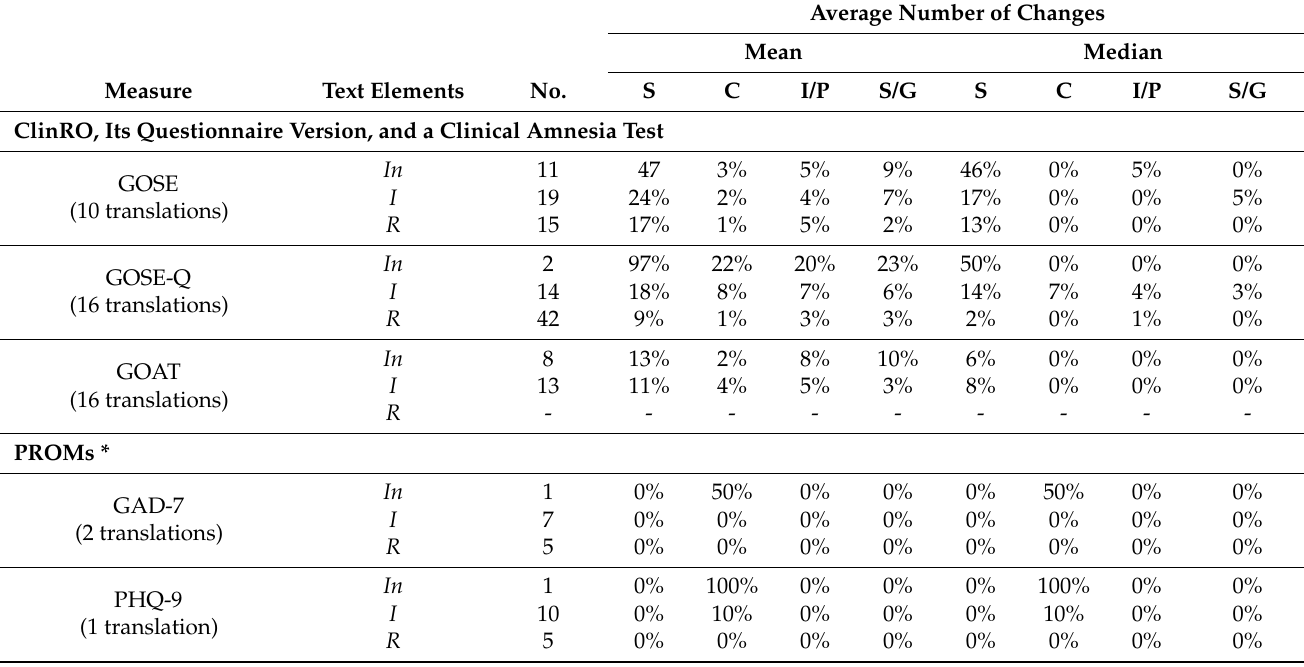
Table 5. Average (mean and median) number of differences between the original English version and the first harmo- nized